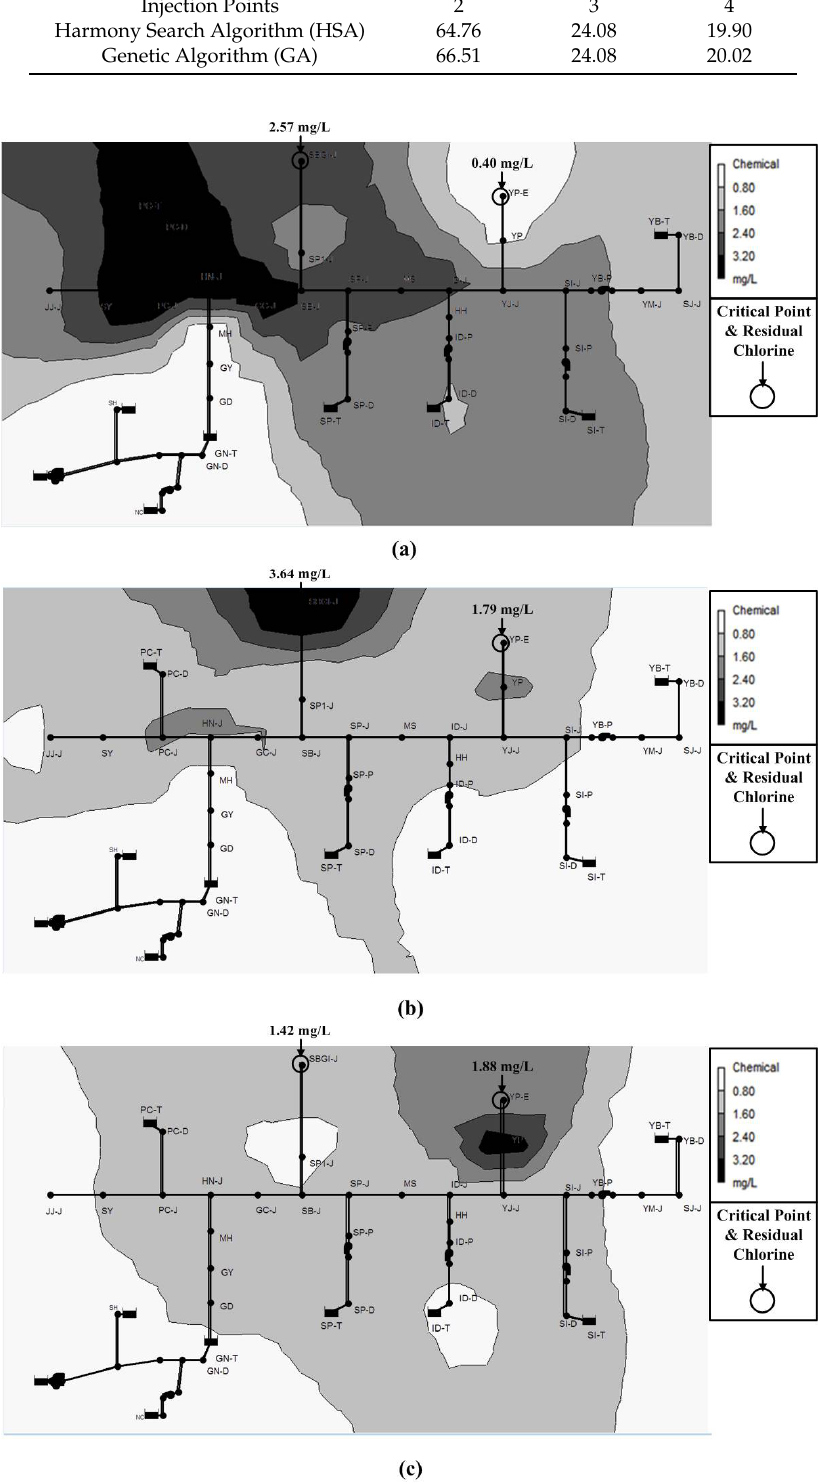
Figure 7. Spatial distributions of residual chlorine: ( a ) two points, ( b ) three points, and ( c ) four points (P-City, network 1).